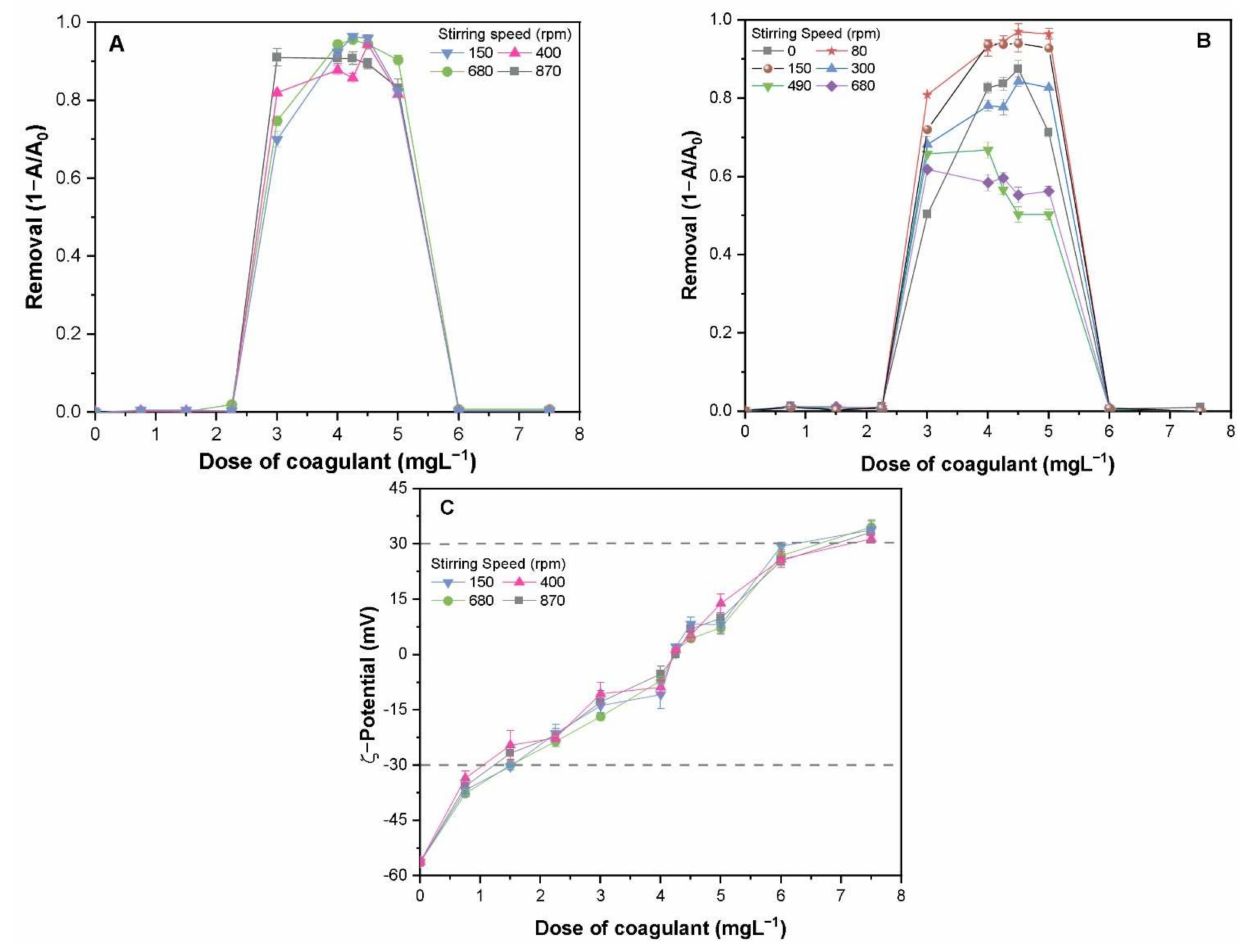
Figure 2. Removal efficiencies of TA-CuO NPs under various stirring speeds and PAFC dosages: ( A ) mixing phase, ( B ) reacting phase, and ( C ) ζ − potential of TA-CuO